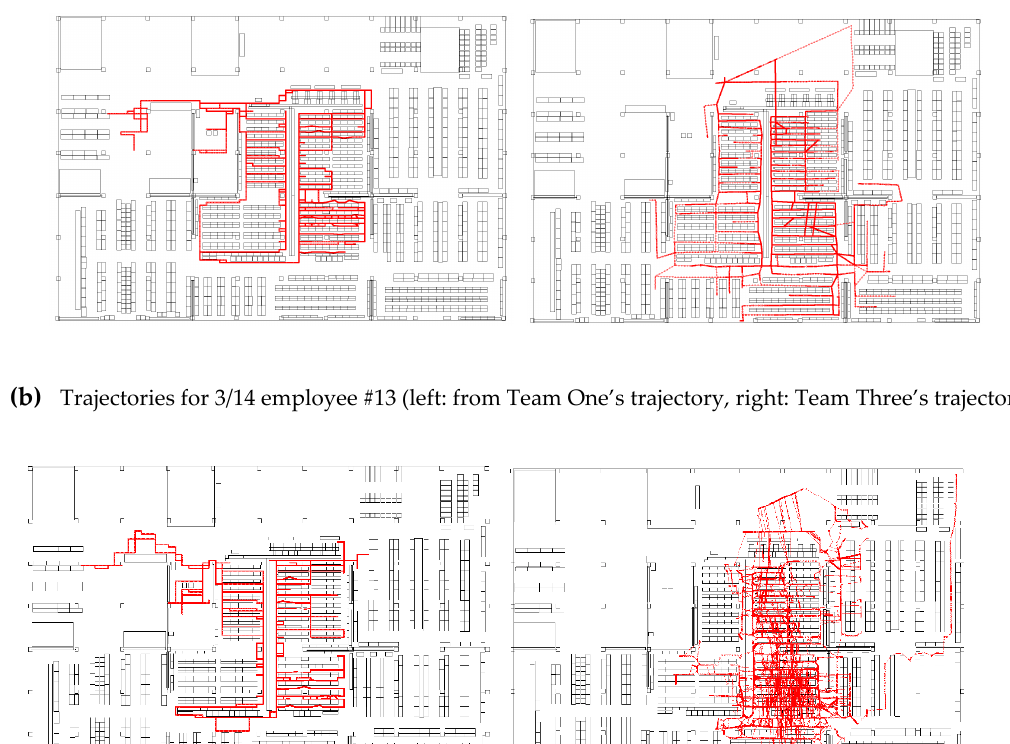
Figure 15. Examples of trajectories in the VDR track ( Top Left : 3/15 Dev#57, Top Right : 3/19 Dev#57, Bottom Left : 3/14 Dev#13, Bottom Right : 3/19 Dev #5).